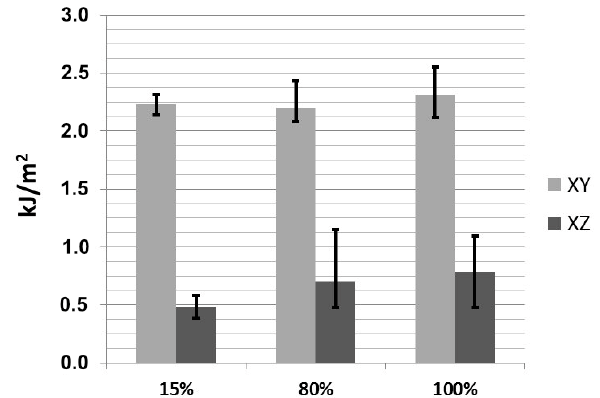
Figure 5. Charpy impact test results.